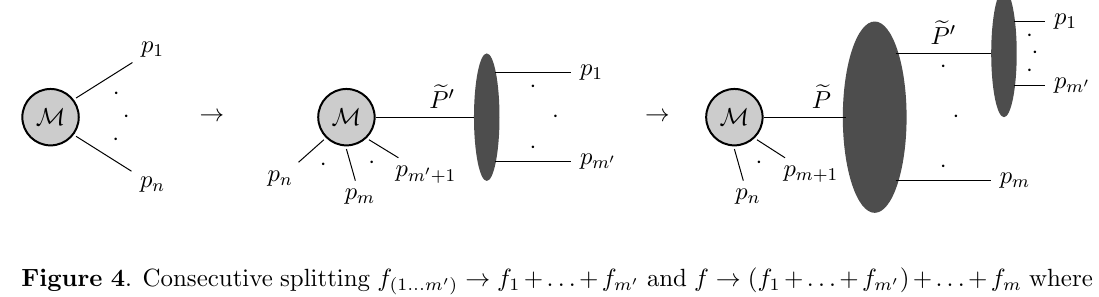
Figure 4 . Consecutive splitting f the partons with momenta